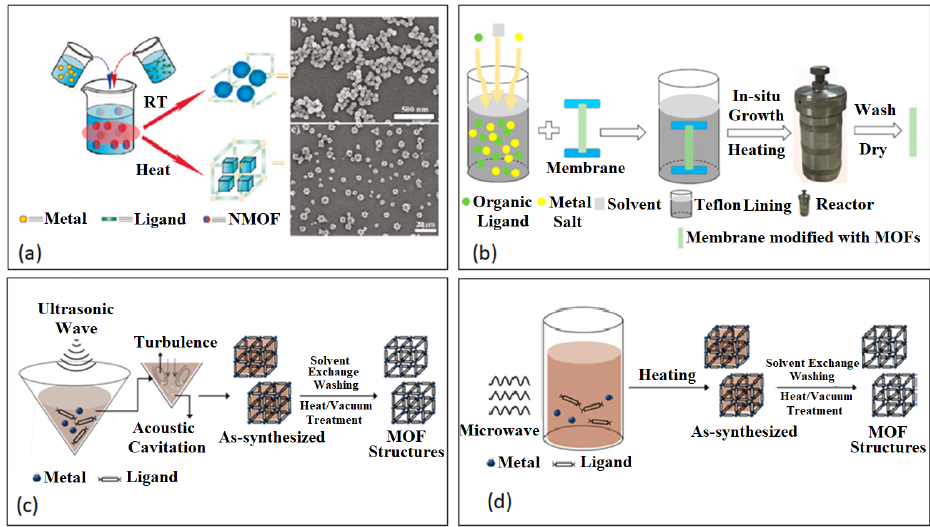
Figure 3. Various methods of MOF synthesis. ( a ) Low temperature synthesis. Reproduced with permission from Ref. [121]. Copyright © 2011, American Chemical Society. ( b ) Solvothermal/hydrothermal. Reproduced with permission from Ref. [122]. Copyright © 2018, MDPI. ( c ) Sonochemical. Reproduced with permission from Ref. [123]. Copyright © 2013, Springer. ( d ) Microwave-assisted solvothermal synthesis. Reproduced with permission from Ref. [123]. Copyright © 2013, Springer.